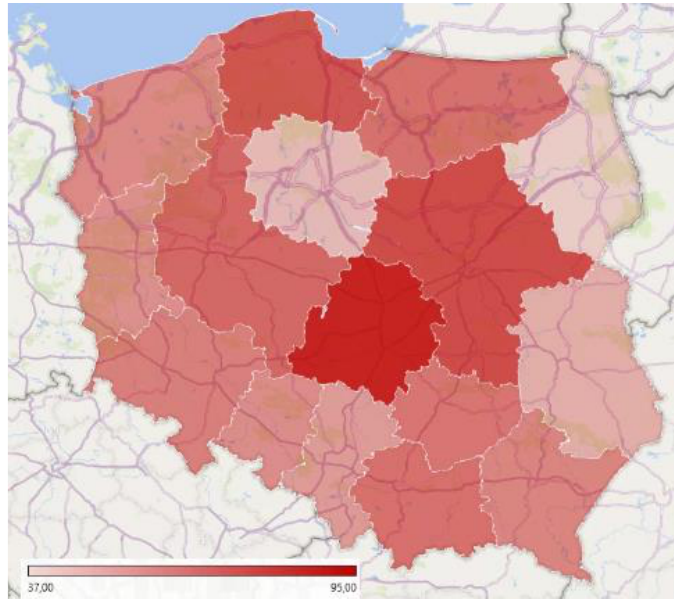
Figure 3. Accident number per 100,000 population in 2020 [62].